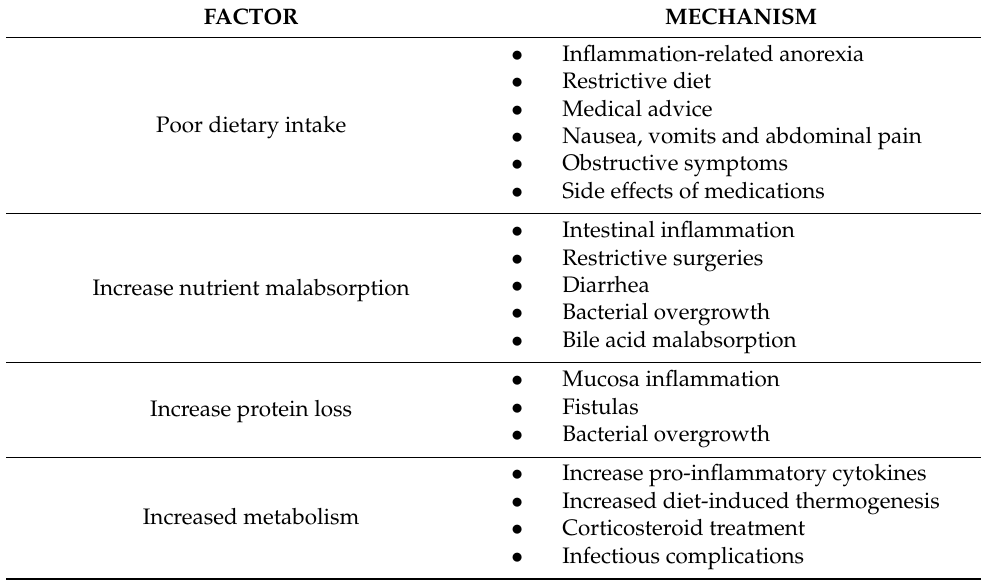
Table 2. Factors that contribute to malnutrition in IBD